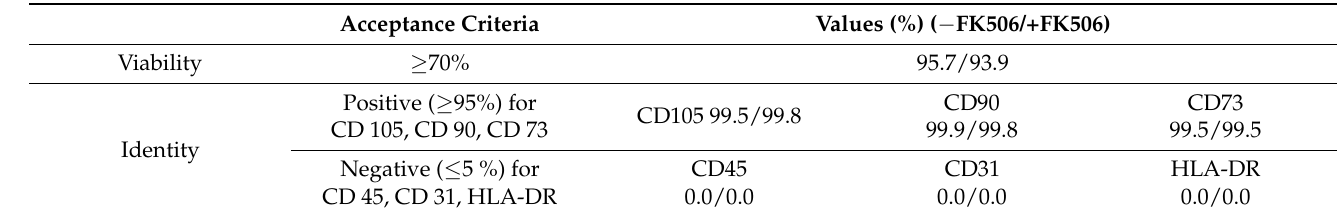
Table 3. Viability and immunophenotype of cells after 8 days in culture in the presence or absence of FK506.